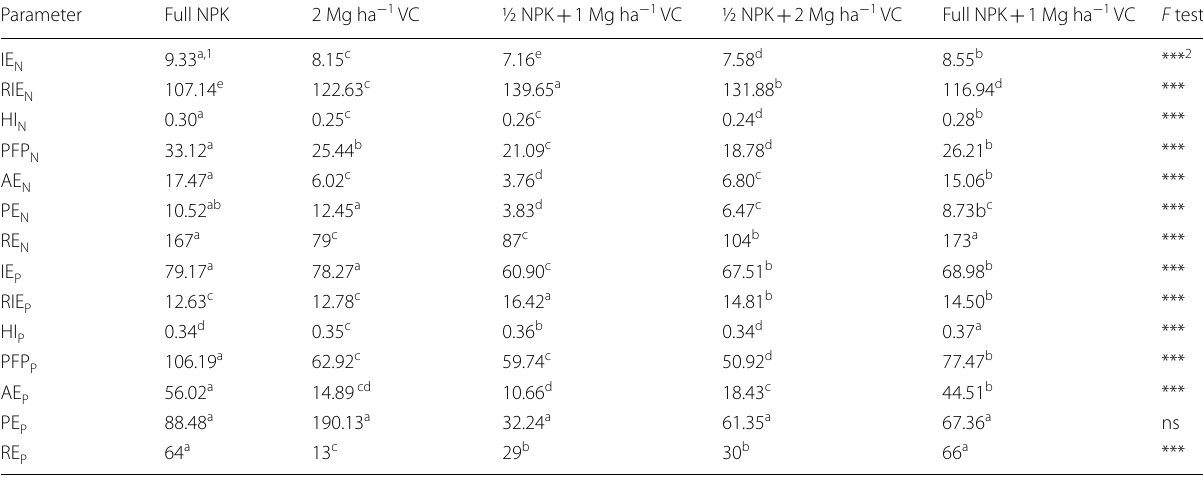
Table 1 N and P harvest index (HI) (kg kg − 1 ), internal efficiency (IE) (kg kg − 1 ), reciprocal internal efficiency (RIE) (kg t − 1 ), agronomic